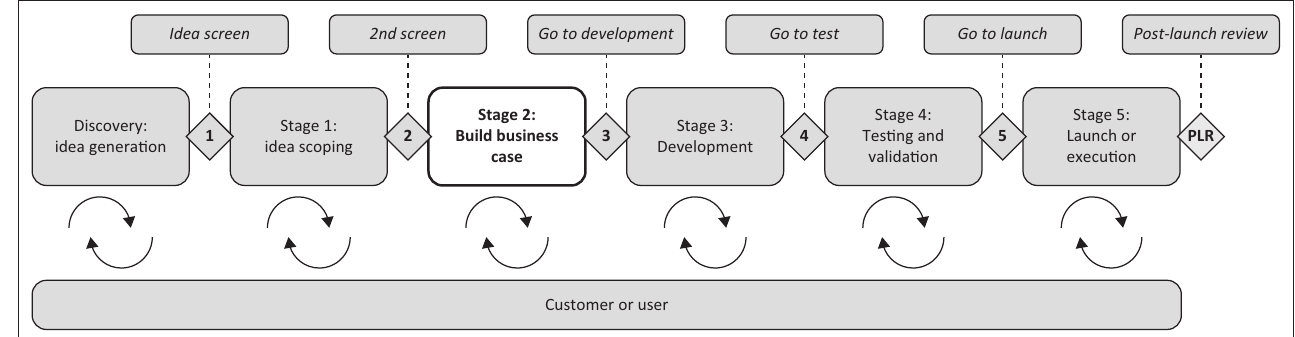
FIGURE 1: Idea-to-launch stage-gate